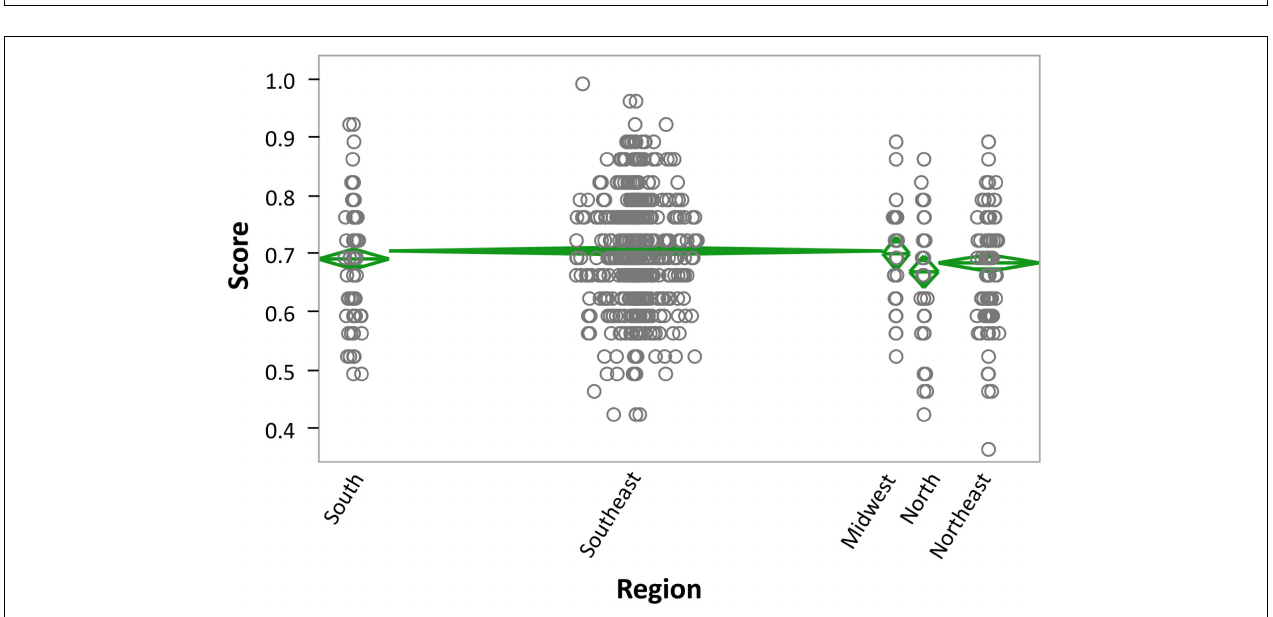
FIGURE 2 | Age × overall score. Overall score for participants in the different age groups: 10–19 years old, 20–29 years old, 30–39 years old, 40–49 years old, 50–59 years old, and 60 or older. Data are shown in mean diamond graphs, where the width of the diamond is directly proportional to the sample size, and the height corresponds to the variance. No intersection between diamonds implies rejection of the null hypothesis for an α error of 5%. The circle markers represent each participant’s score.